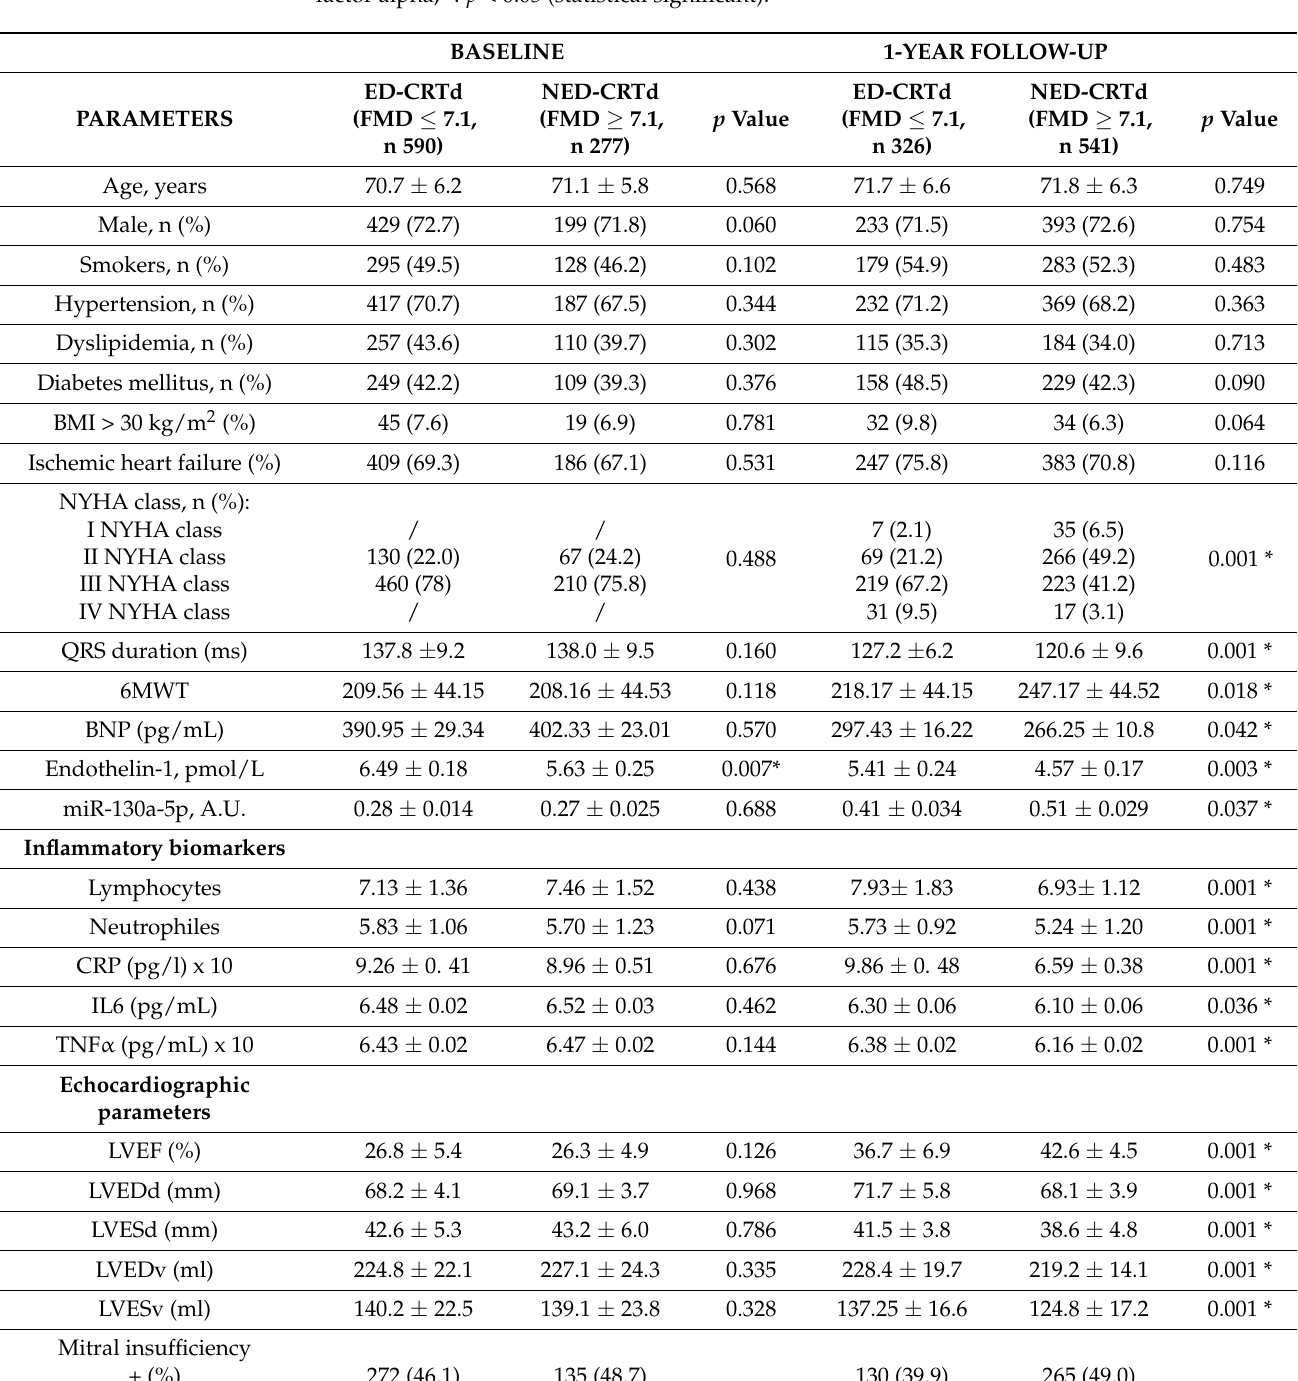
Table 1. Clinical characteristics of study population at baseline and at end of follow-up for ED-CRTd vs. NED-CRTd. ACE: angiotensin-converting enzyme; ARS: angiotensin receptor; A.U.: arbitrary unit; BMI: body mass index; BNP: B-type natriuretic peptide; COPD: chronic obstructive pulmonary disease; CRP: C-reactive protein; ED: endothelial dysfunction; IL6: interleukin 6; miR-130: microRNA- 130; NYHA: New York Heart Association; LVEF: left ventricle ejection fraction; LVEDd: left ventricle end diastolic diameter; LVEDv: left ventricle end diastolic volume; LVESd: left ventricle end systolic diameter; LVESv: left ventricle end systolic volume; mitral insufficiency +: low-grade; ++: moderate; +++: more than moderate; NOAC: new oral anticoagulant; SGLT2-I: sodium–glucose transporter 2 inhibitors; NED: non-endothelial dysfunction; 6MWT: six minutes walking test; TNFa: tumor necrosis factor alpha; *: p < 0.05 (statistical